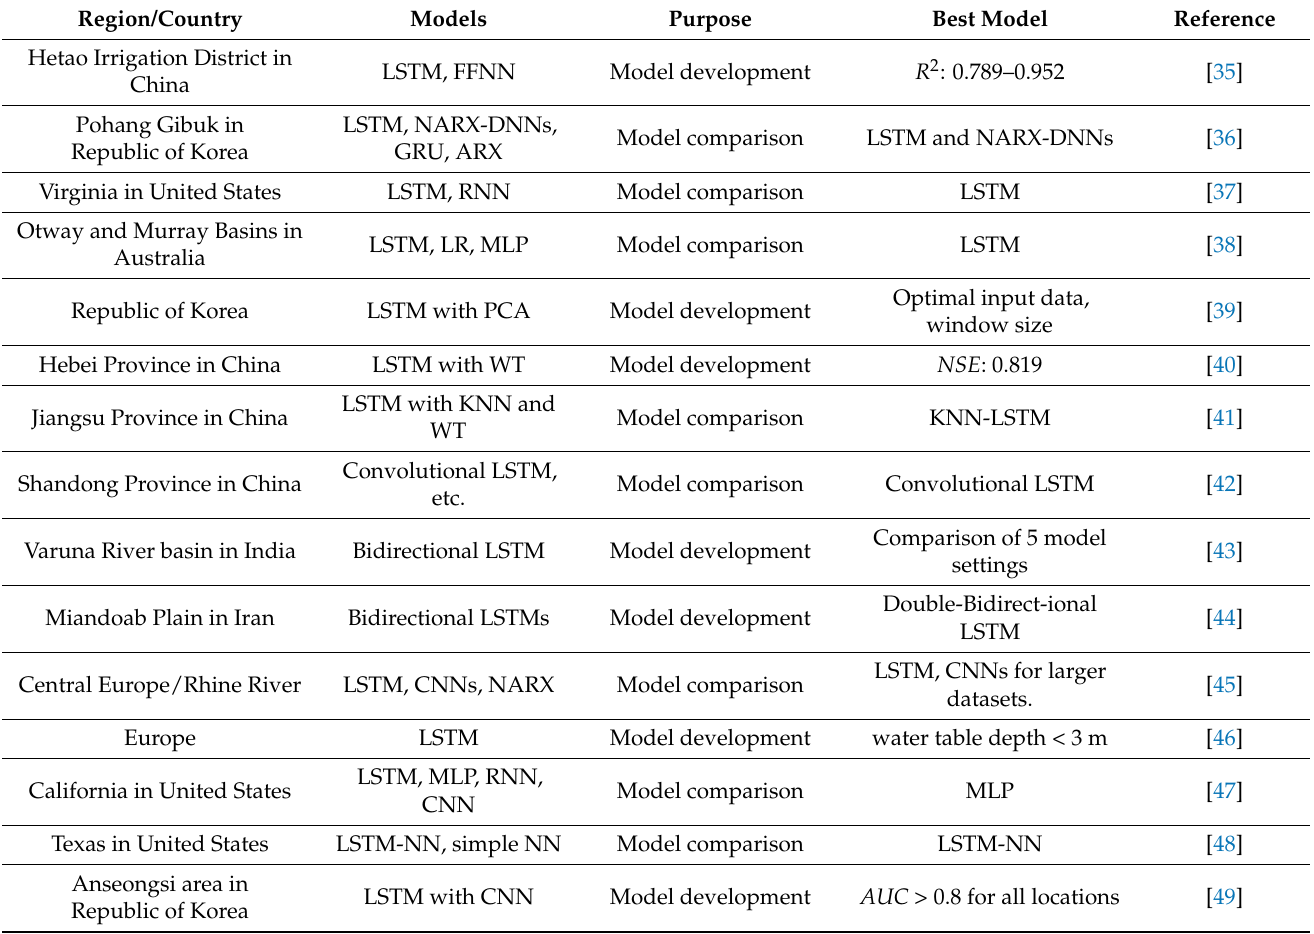
Table 1. List of the recent machine and deep learning research, including uses of LSTM, in the field of groundwater